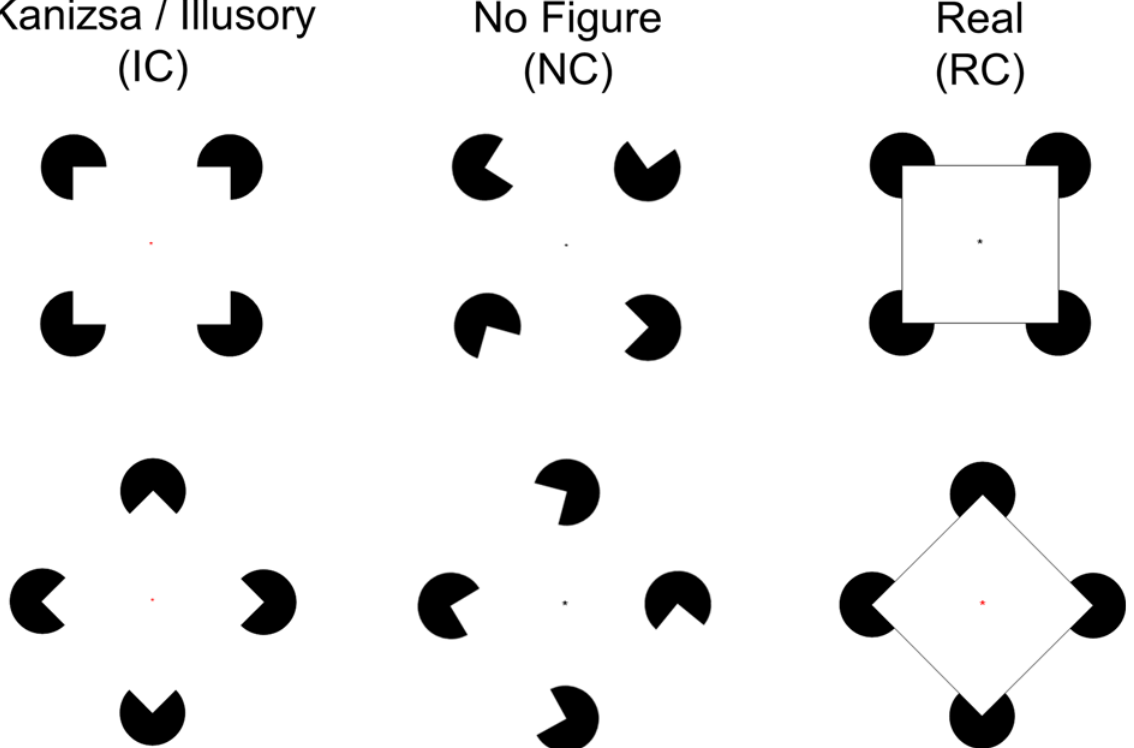
Fig 1. Example of stimuli, comprised either real figures (square or diamond) or no figures. Real figures were composed of either real contours (RC) or illusory contours (IC). No figure stimuli contained no contours (NC). A small fixation dot at the center of the stimulus changed from black to red and vice versa